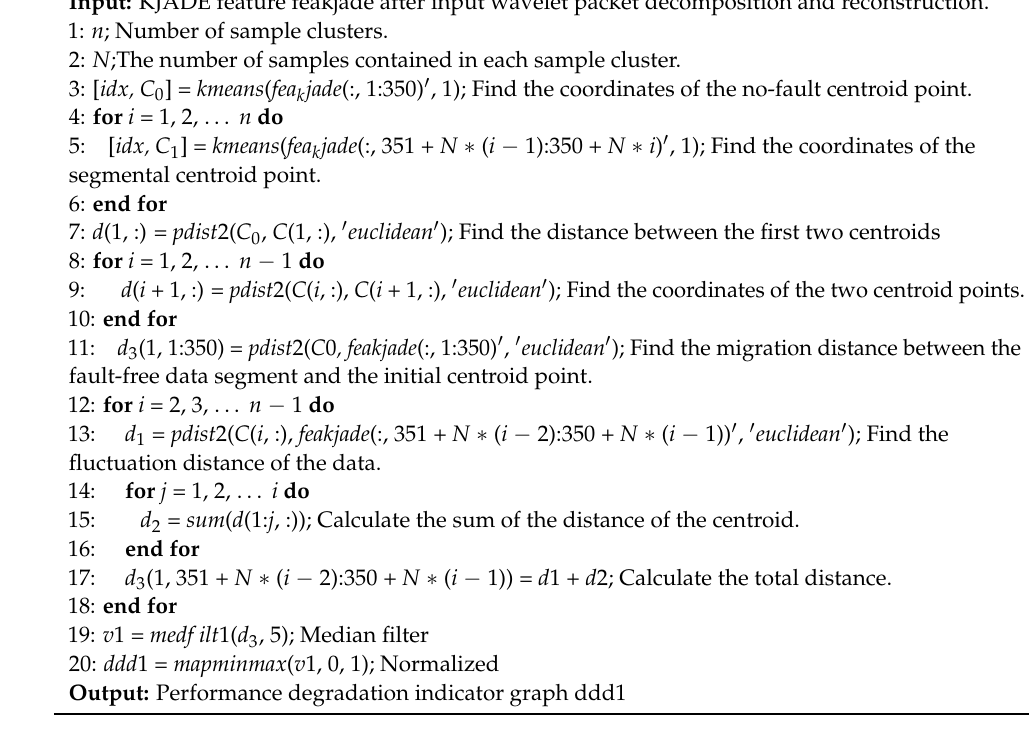
Algorithm 1 Algorithm name: Dynamic centroid algorithm